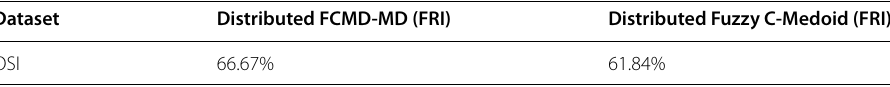
Table 17 Fuzzy Rand Index (FRI) scored by distributed FCMD-MD and Fuzzy C-Medoid on OSI dataset